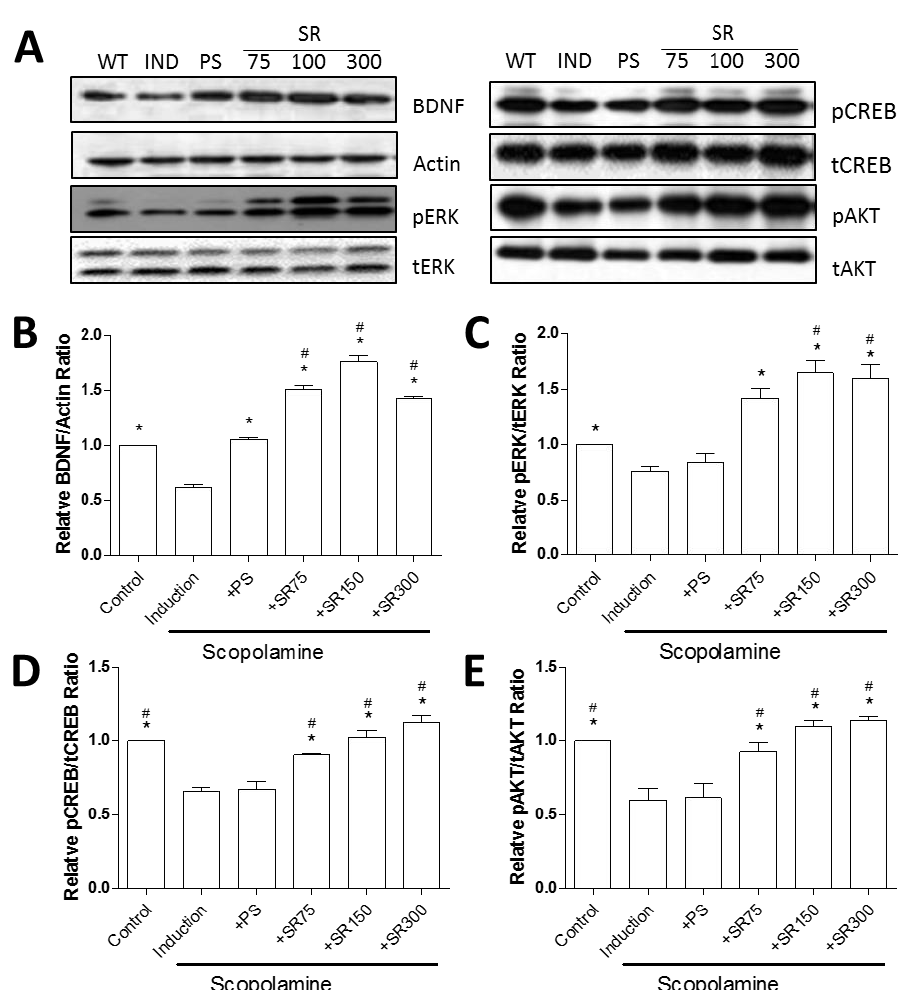
Figure 5. Involvement on brain derived neurotrophic factor (BDNF) signaling pathway for treatment of SC and RF extracts. Rats were treated orally with SC + RF (SR) (75, 150, or 300 mg / kg / day) for 28 days. Hippocampus was extract 30 min after an intraperitoneal injection of 1 mg / kg scopolamine. Western blot analysis with specific antibodies and Actin was used for loading control ( A ). Relative band ratio was calculated with image J ( B – E ). *: p < 0.05 vs. Scopolamine induction. #: p < 0.05 vs. PS. Abbreviation: PS, phosphatidylserine. SCO,